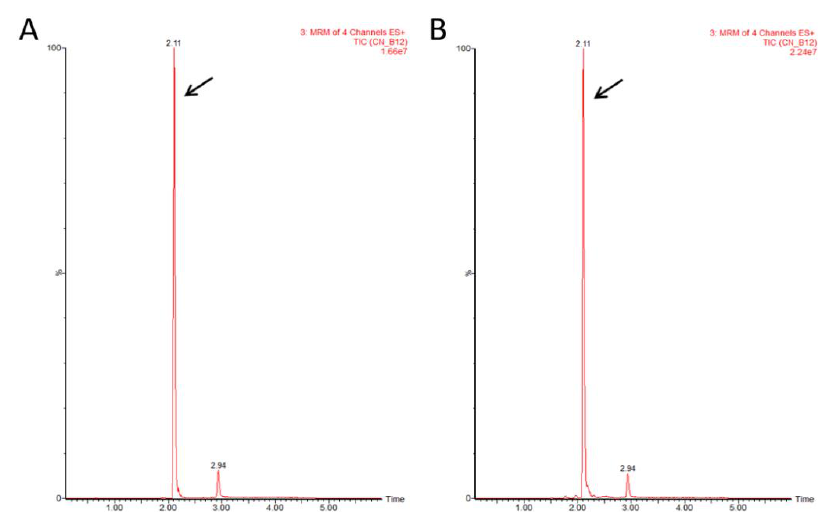
Figure 2. Liquid chromatography/electrospray ionization tandem mass spectrometry (LC-MS/MS) chromatograms of CN-B 12 . ( A ). Retention time for CN-B 12 standard (arrow). ( B ). Retention time for CN-B 12 extracted from Mankai sample (arrow). ES, electrospray; MRM, multiple reaction monitoring; TIC, total ion current.